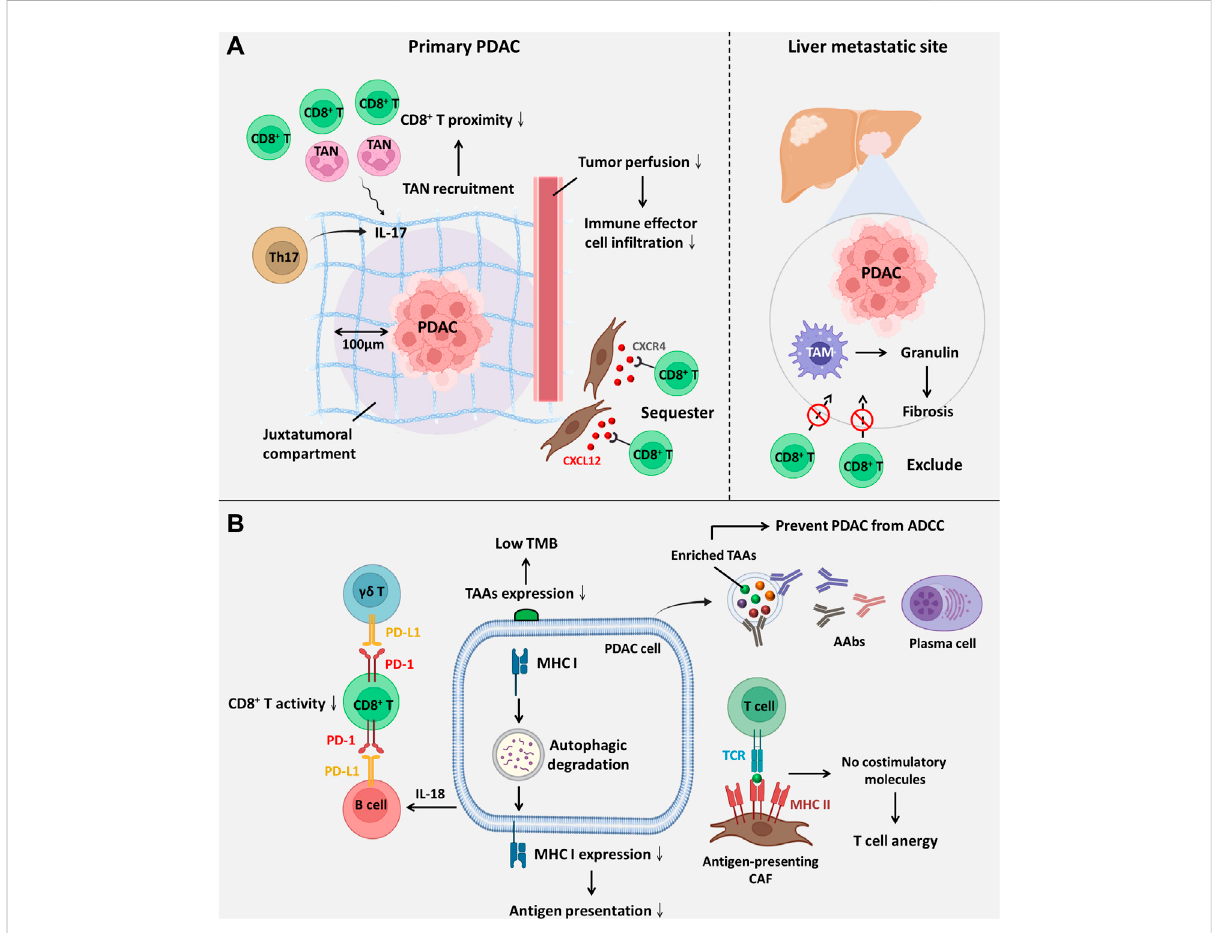
FIGURE 2 The components within the PDAC TME facilitate ICI resistance. (A) ICI resistance mediated by spatial exclusion of CD8 + T cells is primarily facilitated by the accumulation of tumour-in fi ltrating neutrophils and excessive ECM deposition. (B) ICI resistance induced by low immunogenicity and dysfunction of CD8 + T-cell ICI ef fi cacy is compromised by downregulated antigenic presentation and reduced CD8 + T-cell activity. Abbreviations: AAbs, autoantibodies; ADCC, antibody-dependent cell-mediated cytotoxicity; CXCL12, C-X-C motif chemokine ligand